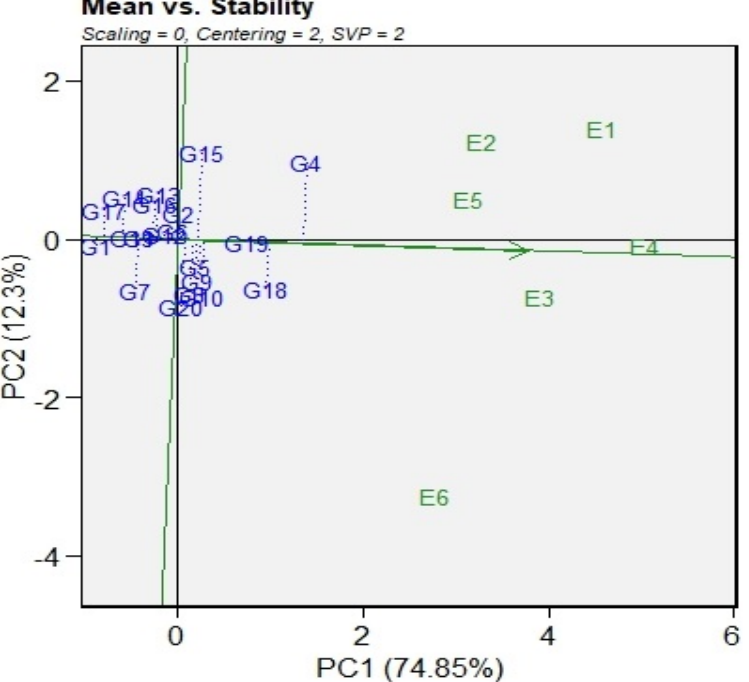
Figure 6. The “mean vs. stability” view showing 20 wheat genotypes’ mean performance and stability across six test environments. The genotype (G) code is indicated according to Table 6.